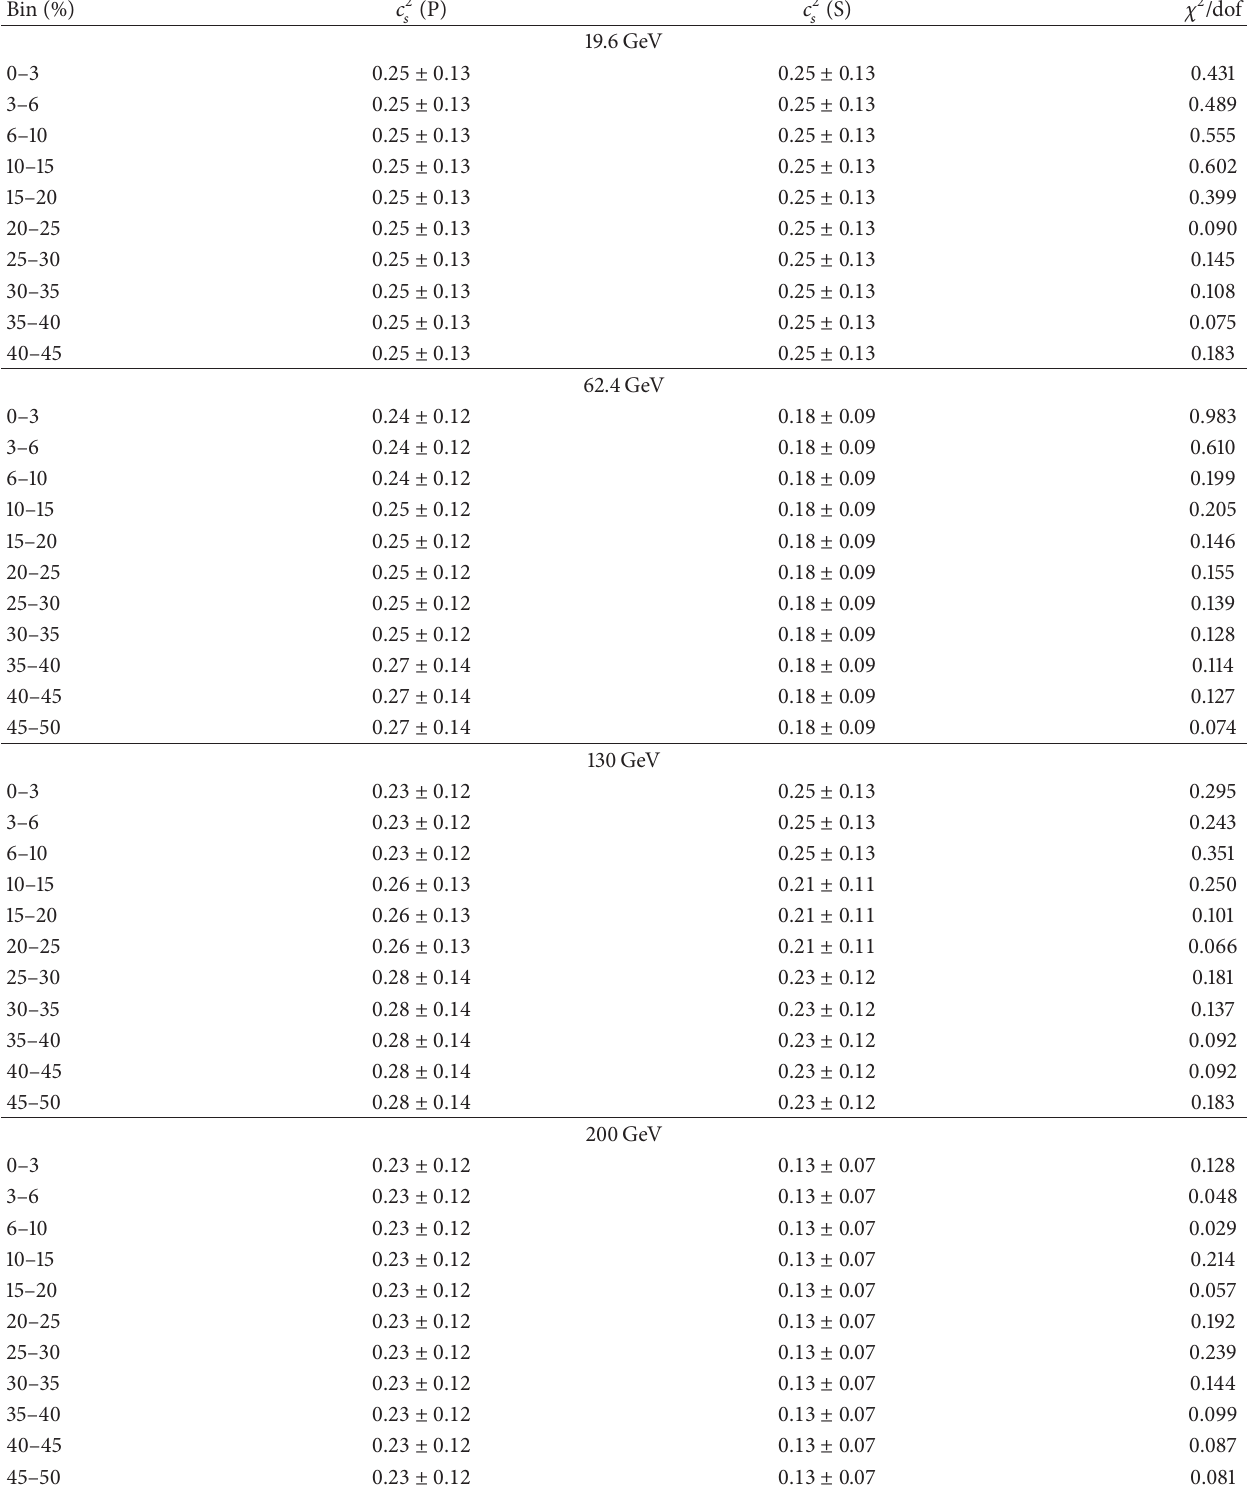
Table 1: Values of 𝑐 2 𝑠 for the participants (P) and spectators (S) as well as 𝜒 2 /dof for the curves in Figures 1–4 which represent Au-Au collisions at RHIC